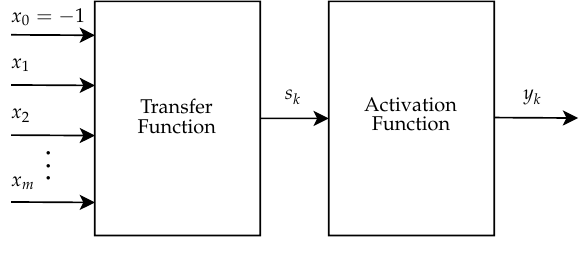
Figure 18. General architecture of the